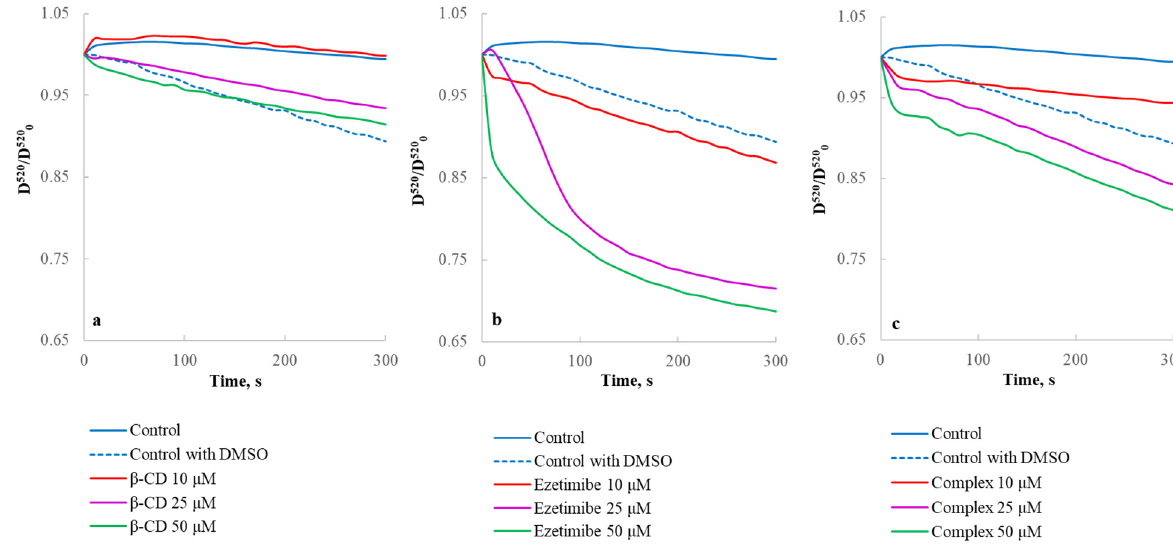
Figure 13. Effect of β CD/ezetimibe/complex ezetimibe- β CD on the process of mitochondrial perme- ability transition pores formation: ( a ) representative curves of mitochondrial swelling in the presence of β CD; ( b ) representative curves of mitochondrial swelling in the presence of ezetimibe; ( c ) repre- sentative curves of mitochondrial swelling in the presence of complex ezetimibe- β CD. Mitochondria (0.5 mg of protein/mL) were added into EDTA-containing medium: 0.24 M sucrose, 0.01 M Tris-HCl, 0.001 M EDTA, pH 7.2, at 25 ° С .